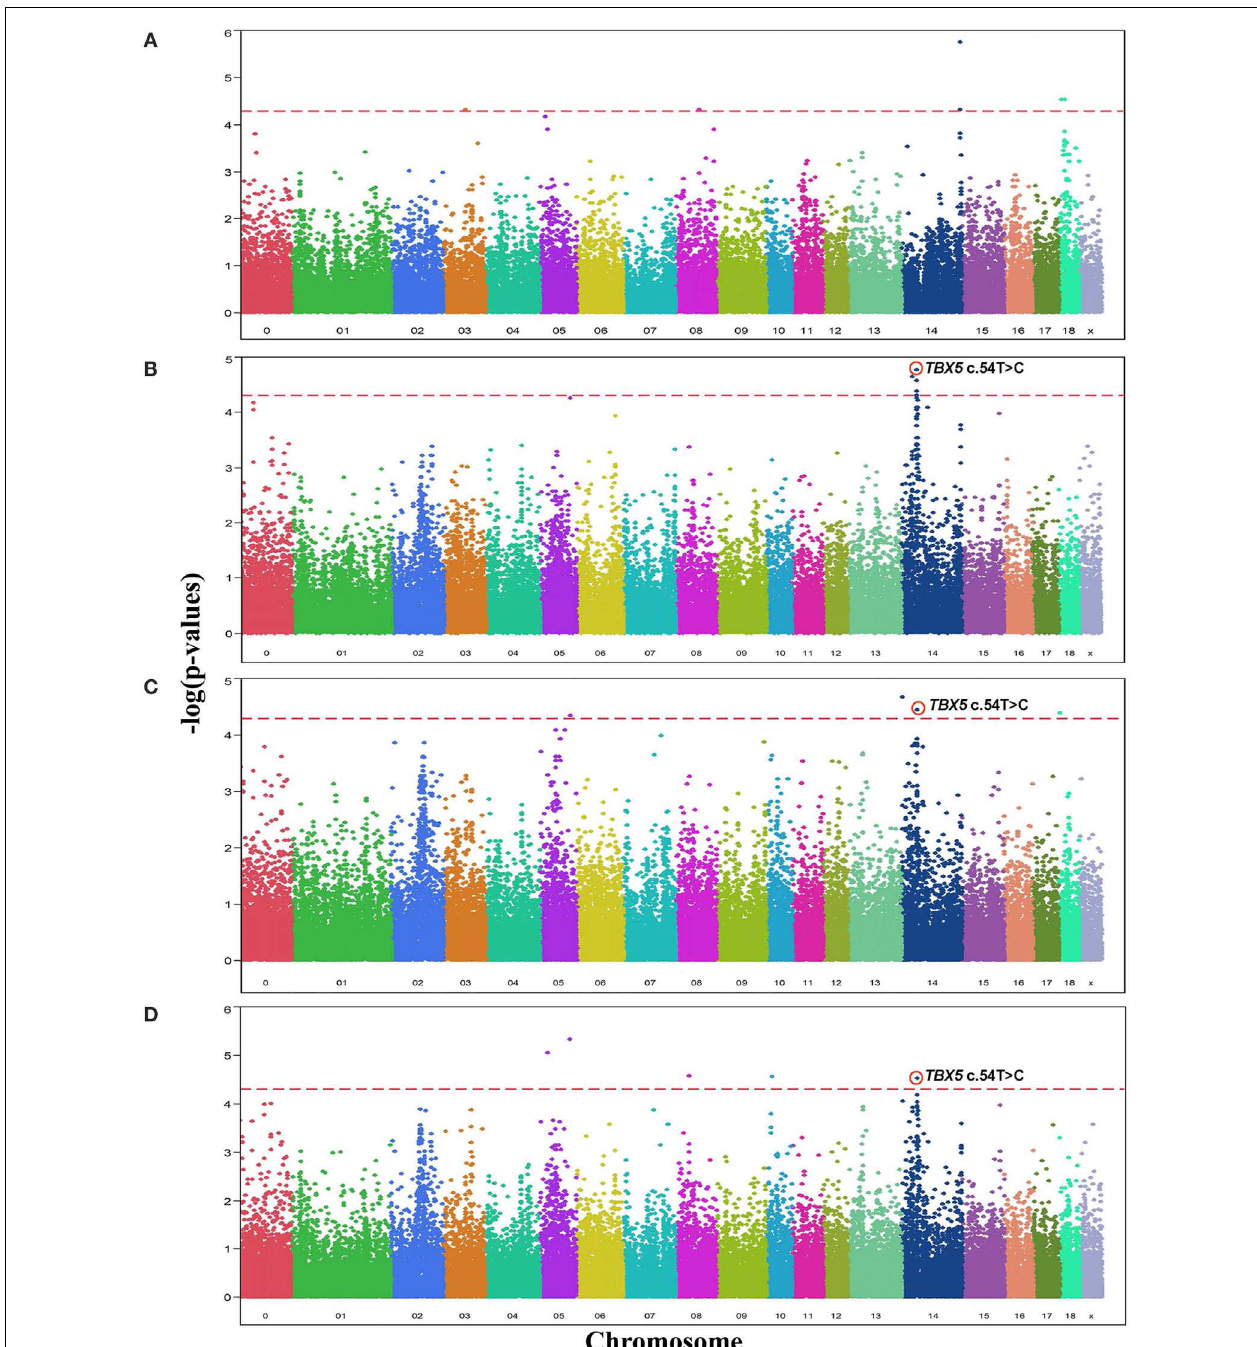
FIGUREA2 | Manhattan plots displaying the significance of associations of SNPs and in particular the SNPTBX5 c.54T > C with OC lesion scores at (A) medial part of condylus humeri (CMH), (B) condylus medialis femoris (CMF), (C) distal epiphyseal cartilage of ulna (DEU), and (D)